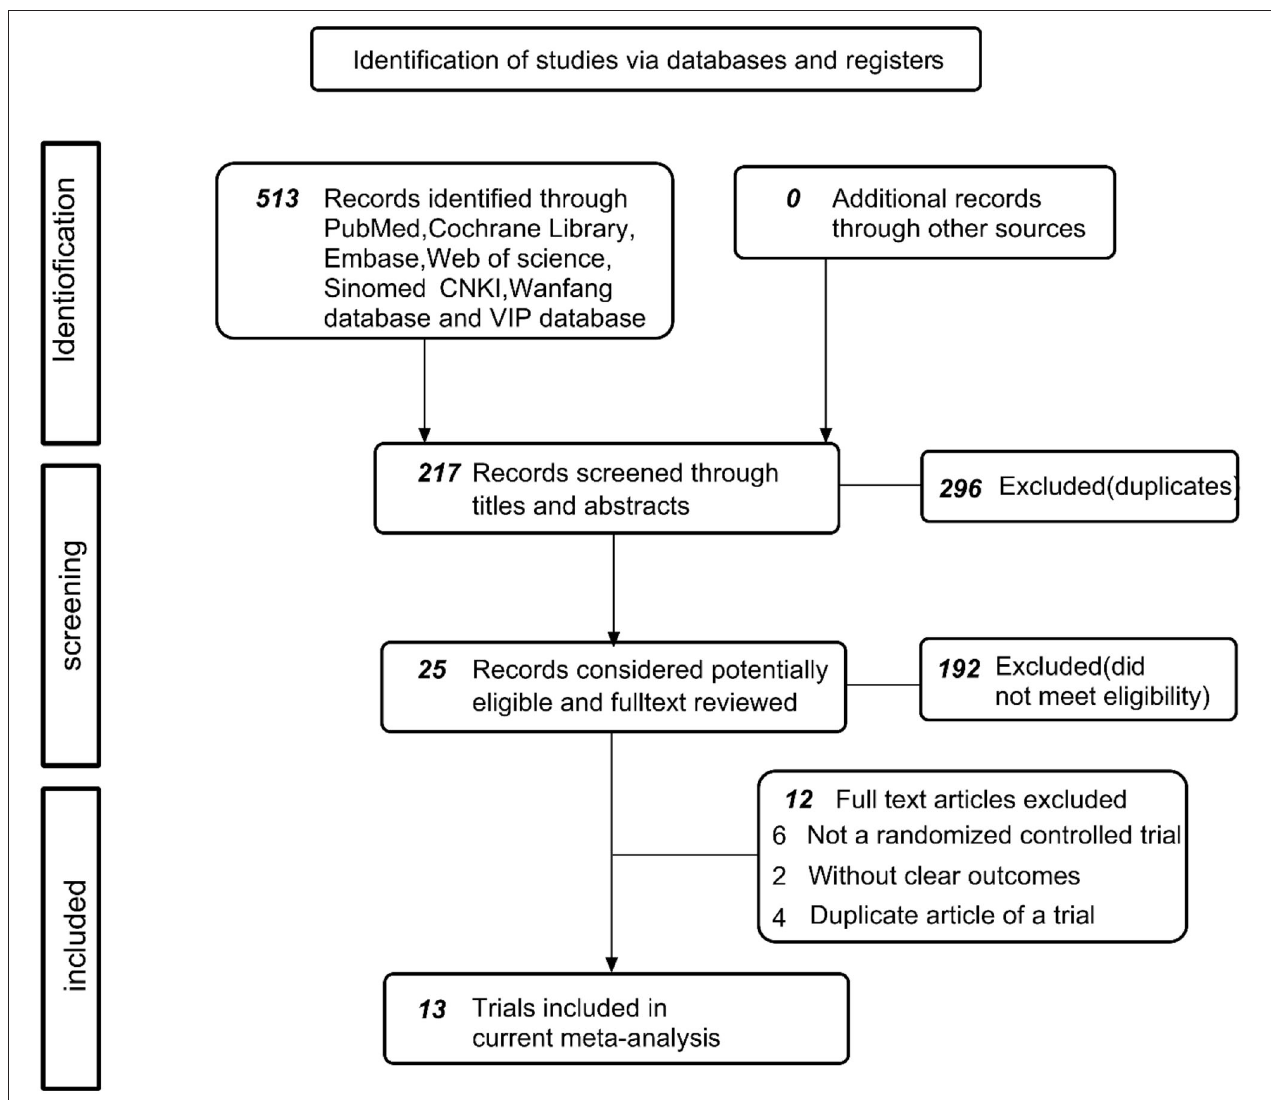
FIGURE 1 | Flow chart of the number of studies identified and included into the